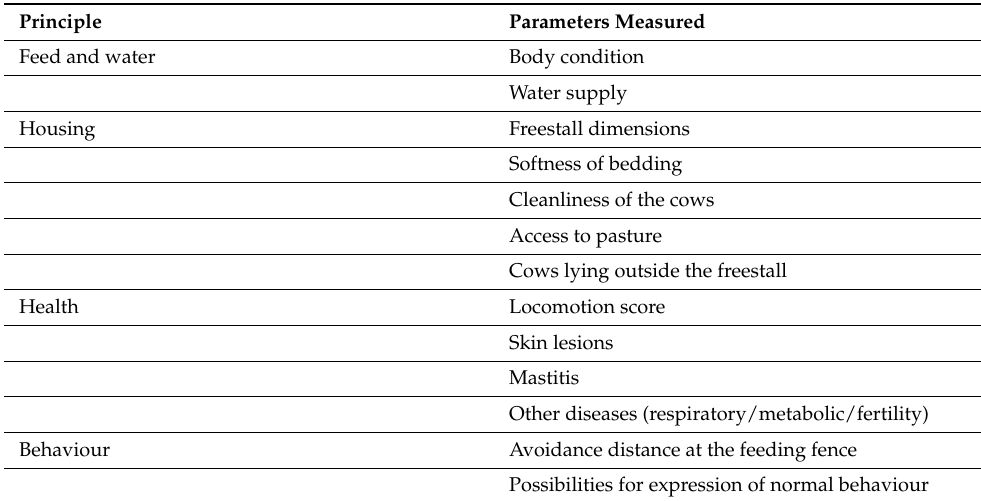
Table 1. Parameters measured in the new Welfare